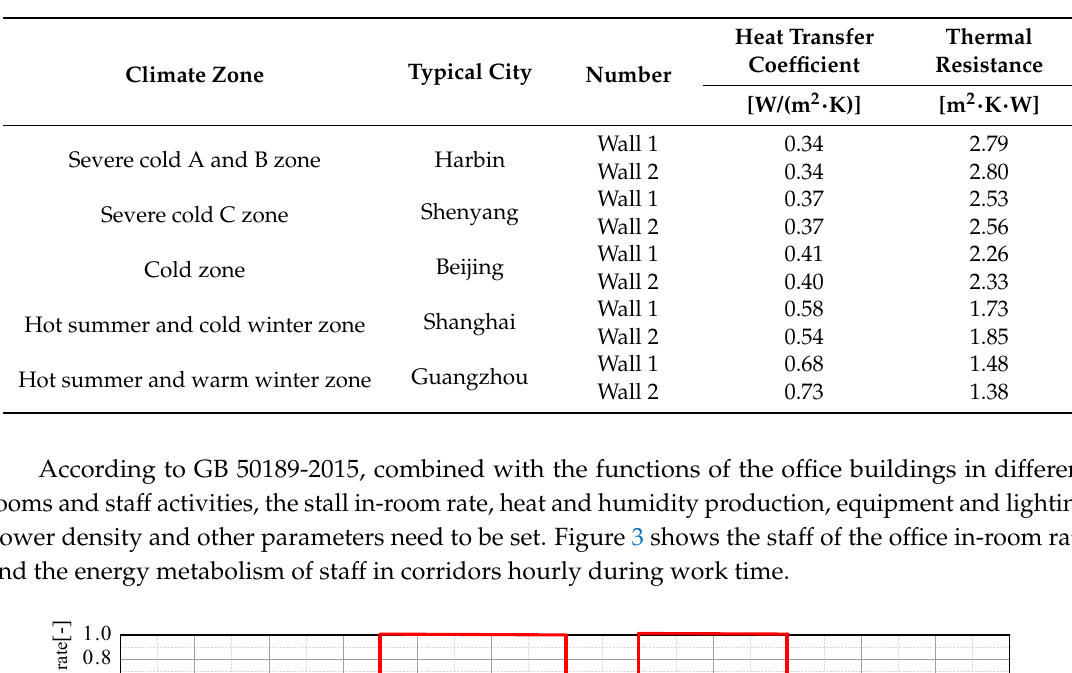
Figure 2. External insulation structure forms. ( a ) EPS external insulation structure form; ( b ) rock wool external insulation structure form. Table 5. Structure of building enclosure in different regions. Table 5. Structure of building enclosure in different regions.